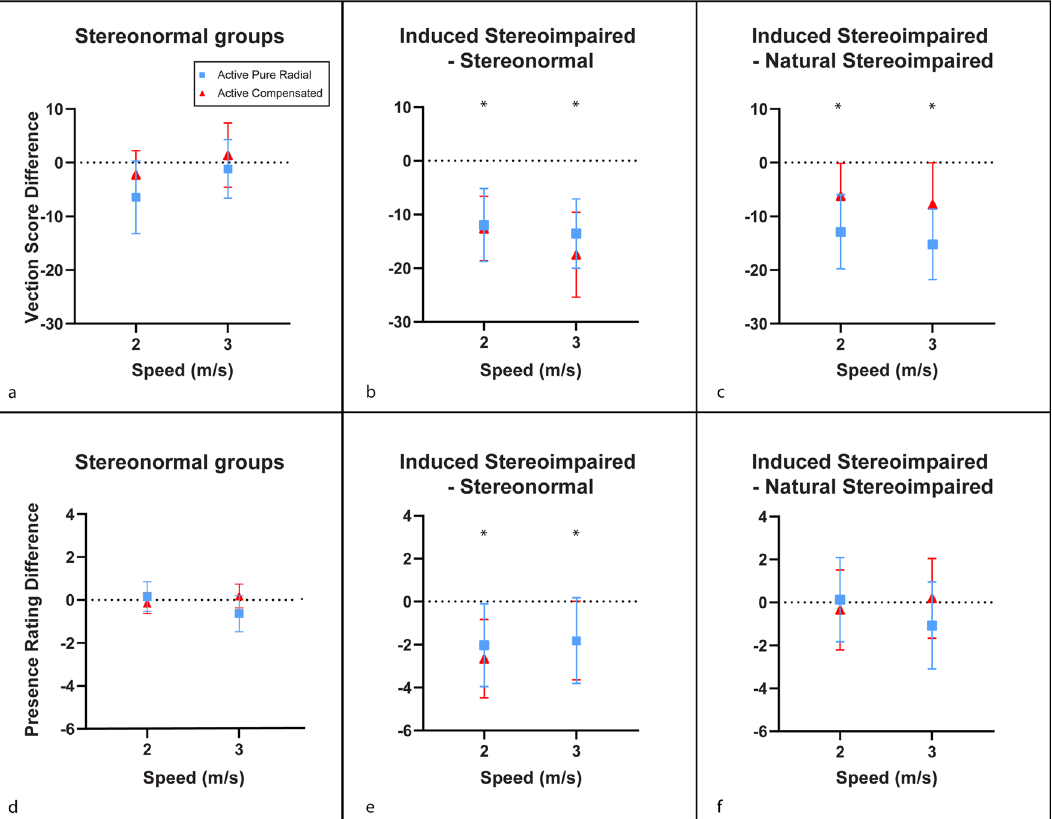
Figure 4. Mean difference plots for vection score (top row) and spatial presence rating (bottom row) during active display configurations. ( a ) and ( d ) compare data on the stereo-normal group before anisometropic suppression in Experiment 1 and the stereo-normal group in Experiment 2; ( b ) and ( e ) show the within-subjects comparison of participants with and without anisometropic suppression in Experiment 1; ( c ) and ( f ) show differences obtained with induced anisometropic suppression relative to participants who naturally do not have global stereopsis. Positive differences indicate advantage of the first listed group compared with the second listed group. Negative differences indicate disadvantage of the first listed group compared with the second listed group. Error bars represent 95% confidence interval. ‘*’ represent p <